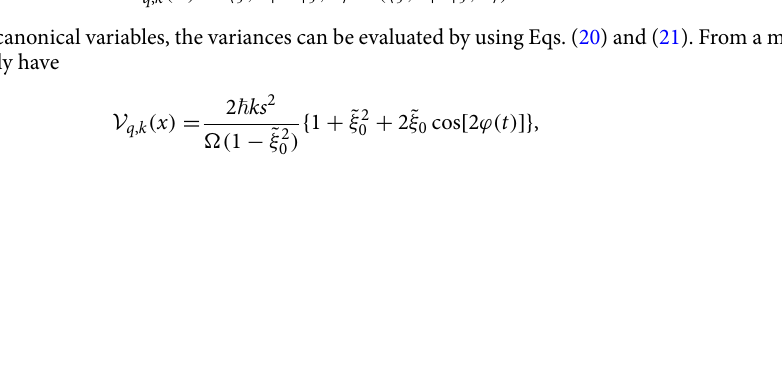
Figure 3. Parametric plot of ˜ ξ( t ) (i.e., ˜ ξ 1 ( t ) and ˜ ξ 2 ( t ) ) on the basis of Eqs. (51) and (52), which are developed using DCOIOT, for two different values of q during a cycle of evolution. We used ω 1 , and ϕ 0 10 , s 0,1 0 ; This choice of parameters gives the initial condition as ( s 0,2 c 1 c 2 = = = = = 0). This graphic can also be drawn from a parametric numerical evaluation using Eqs. (37) and (38) under the ( 1, 0 ) choice of the initial condition as ( ˜ ξ 1 ( 0 ) , ˜ ξ 2 ( 0 )) =